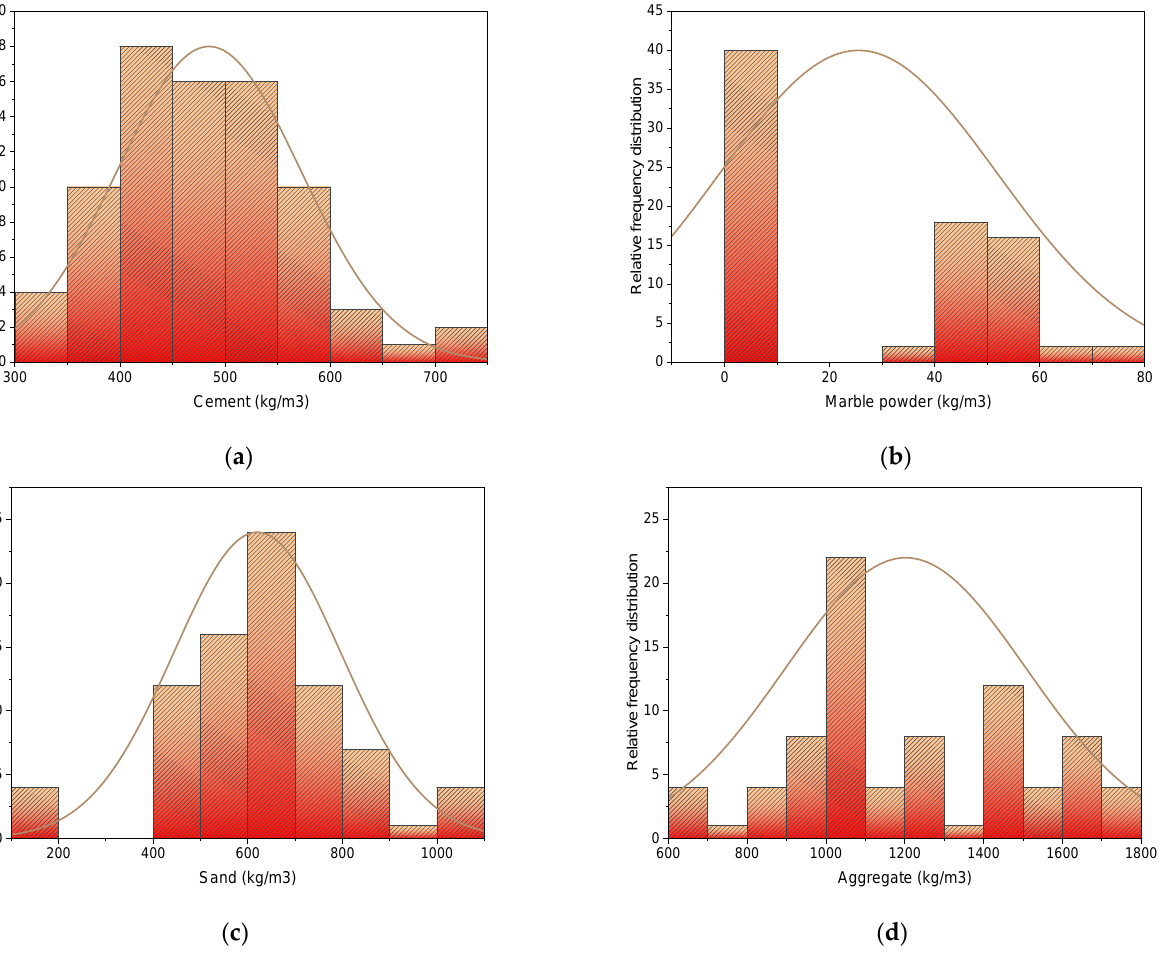
Figure 2. Input parameters relative frequency distribution: ( a ) cement; ( b ) marble powder; ( c ) sand; ( d ) aggregate. Table 4. Input parameters description analysis.